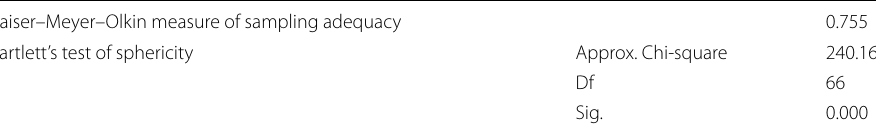
Table 11 KMO and Bartlett’s test (Pre-DeMo, Panchmahal) Kaiser–Meyer–Olkin measure of sampling adequacy Bartlett’s test of sphericity